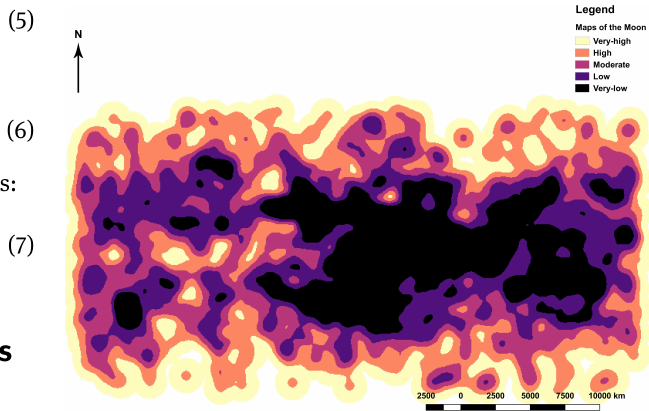
Figure 4. Distribution of Topography of the Moon, divided into 5 classes after GIS